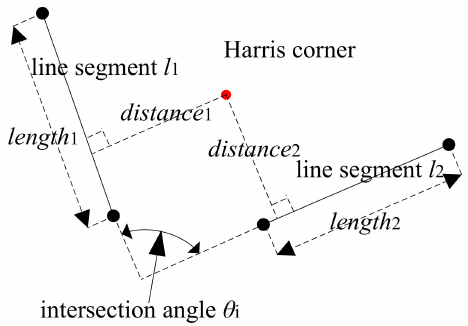
Figure 4. The construction of a right angle corner and two right angle